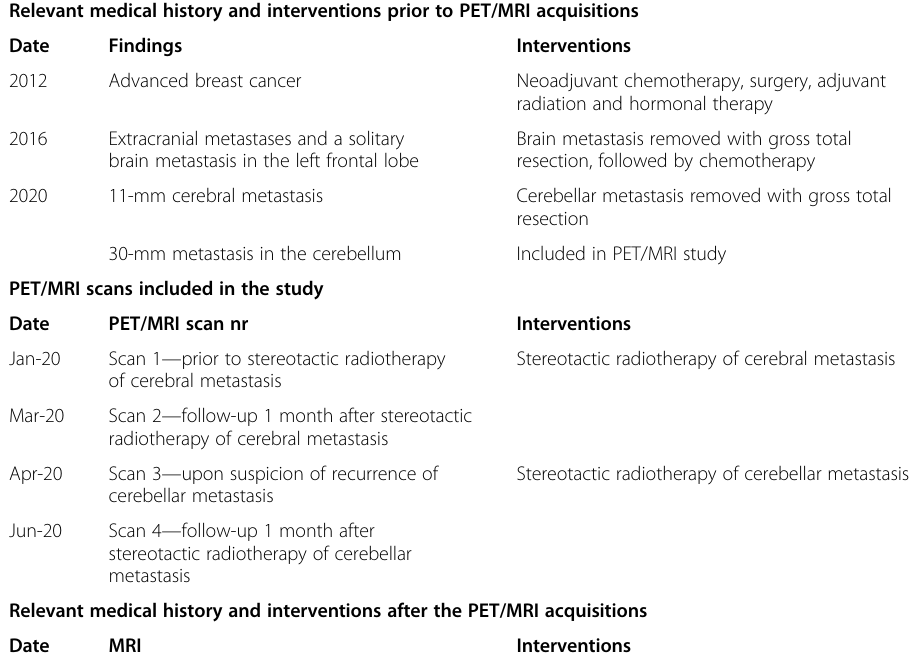
Table 1 Relevant patient medical history and interventions prior to and after PET/MRI acquisitions Relevant medical history and interventions prior to PET/MRI